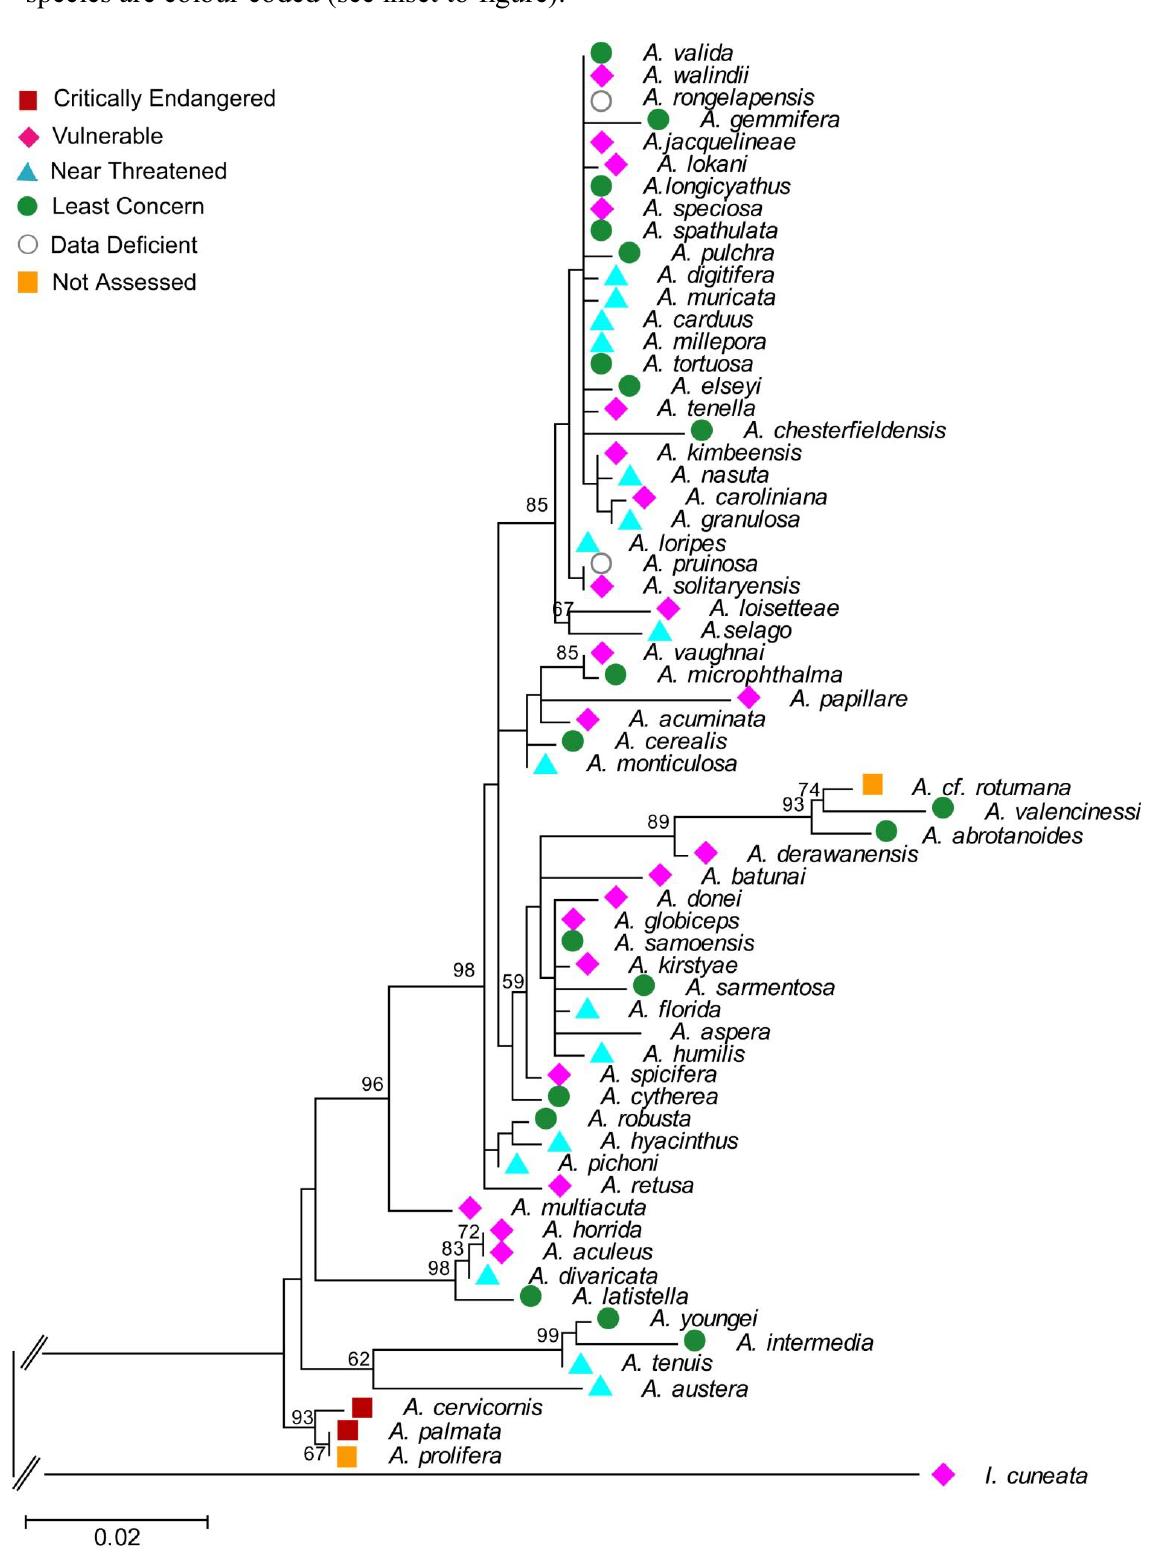
Figure 2. Acropora phylogeny inferred by Maximum Likelihood analysis with bootstrap support values indicated next to branches. The IUCN categories are provided for each species are colour coded (see inset to